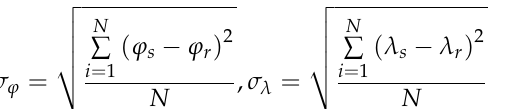
Figure 8. Probability distribution of longitude and latitude error. ( a ) Latitude error distribution; ( b ) Longitude error distribution.